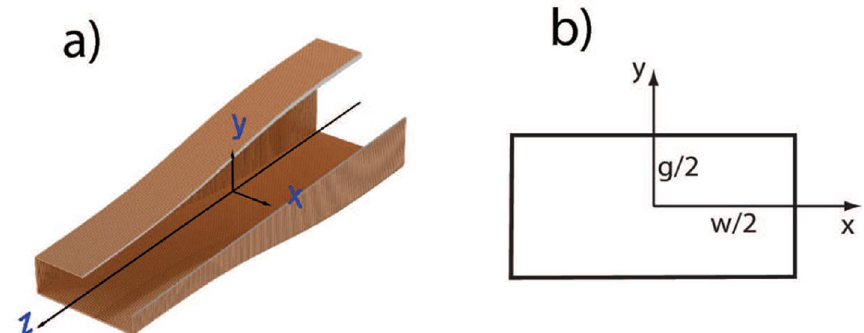
FIG. 3. (Color) A smooth transition with rectangular cross section, (a); the origin of the coordinates (cid:3) x; y (cid:4) is located at the center of the rectangle,